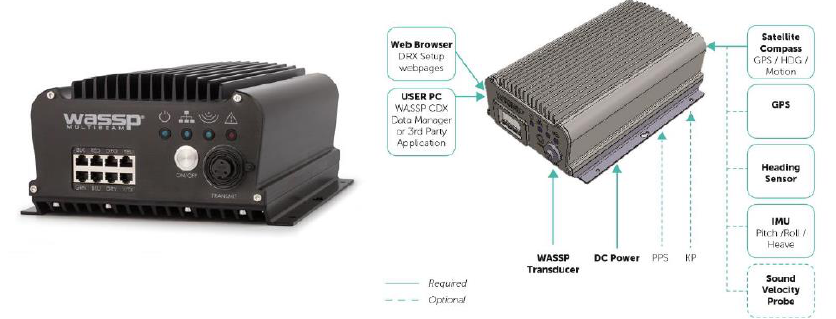
Figure 4. The WASSP S3 multibeam wideband sounder.